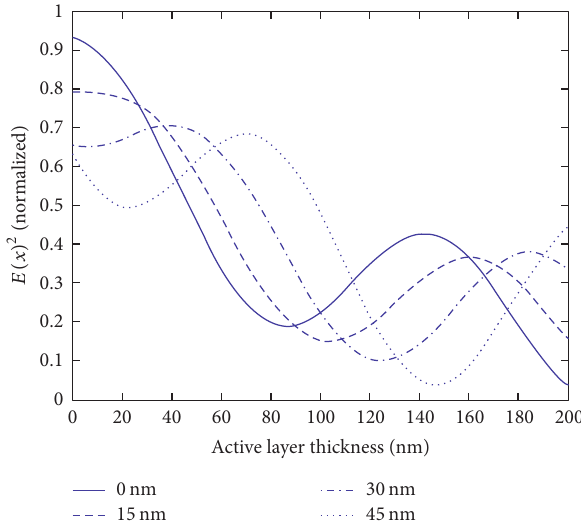
Figure 6: Active layer thickness dependent simulated spatial distri- bution of normalized electric field intensity |𝐸 2 | , assuming a unity IQE and illumination with AM 1.5G for different thicknesses of the ZnO